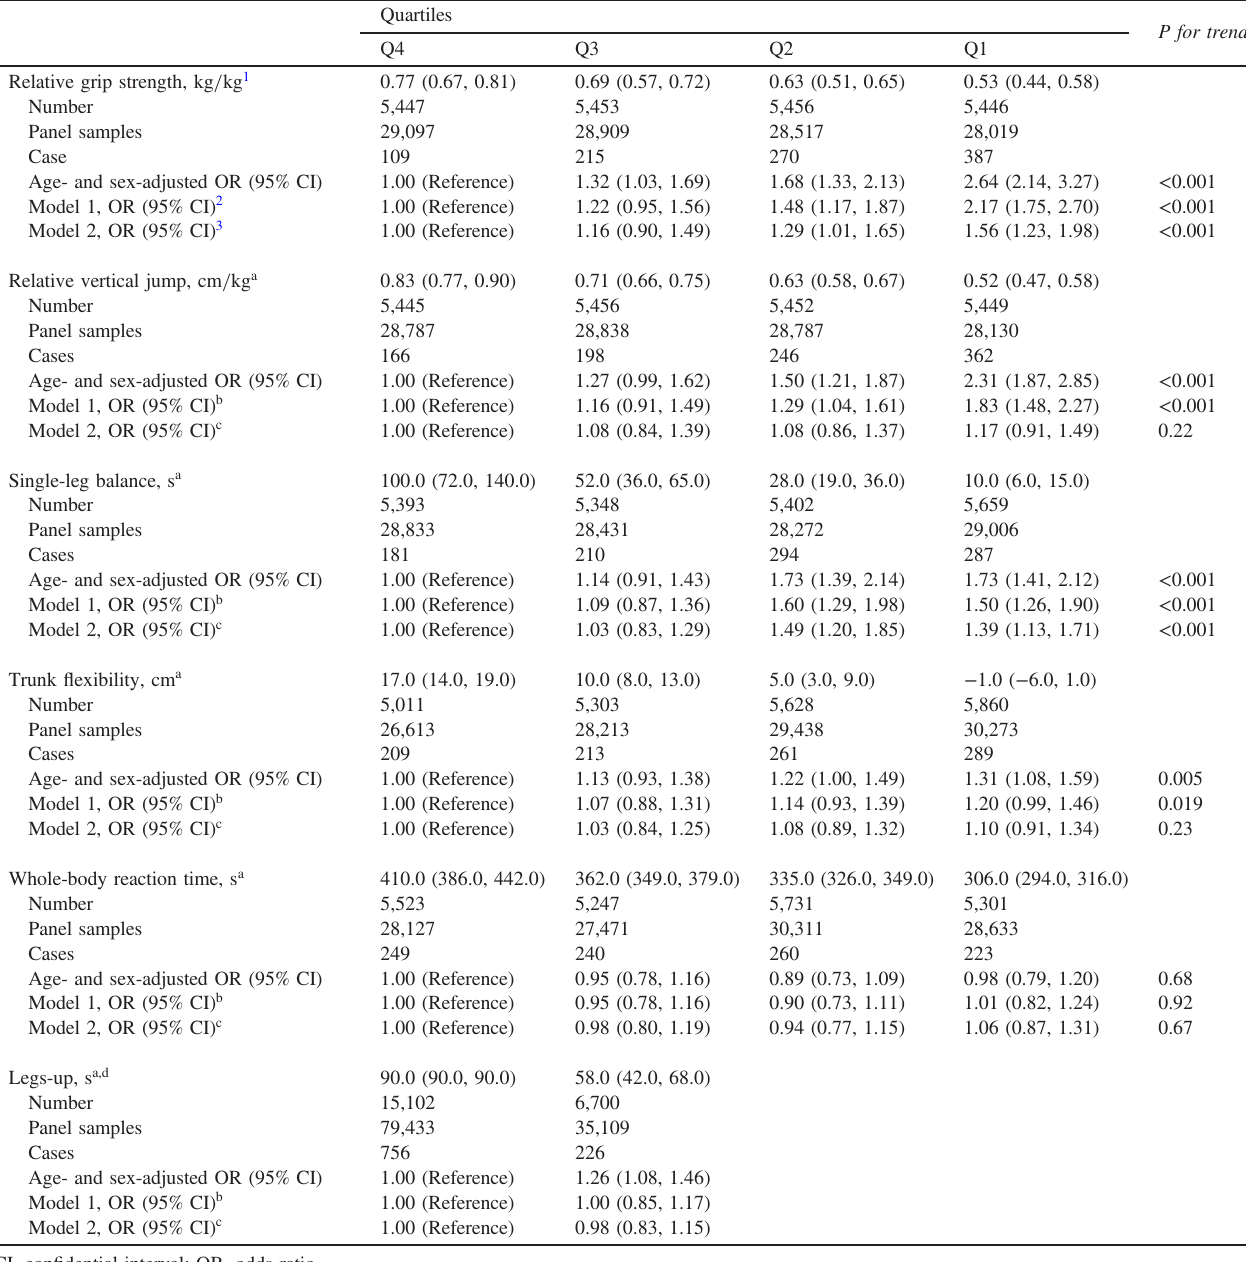
CI, con fi dential interval; OR, odds ratio. a Values are represented as medians (interquartile ranges) at baseline. b Adjusted for age (continuous variable), sex (man or woman), smoking status (never smoker, former smoker, or current smoker), drinking status (none, 1 – 3 days per week, 4 – 6 days per week, or 7 days per week), breakfast skipping (no or yes), hypertension (no or yes), and dyslipidemia (no or yes). c Variables in model 1 plus body mass index (<18.5, ≥ 18.5 and <25.0, ≥ 25.0 and <30.0, or ≥ 30). d Because 69.3% of participants could keep their legs up for 90s, this variable was categorized into 2 groups: <90 seconds or ≥